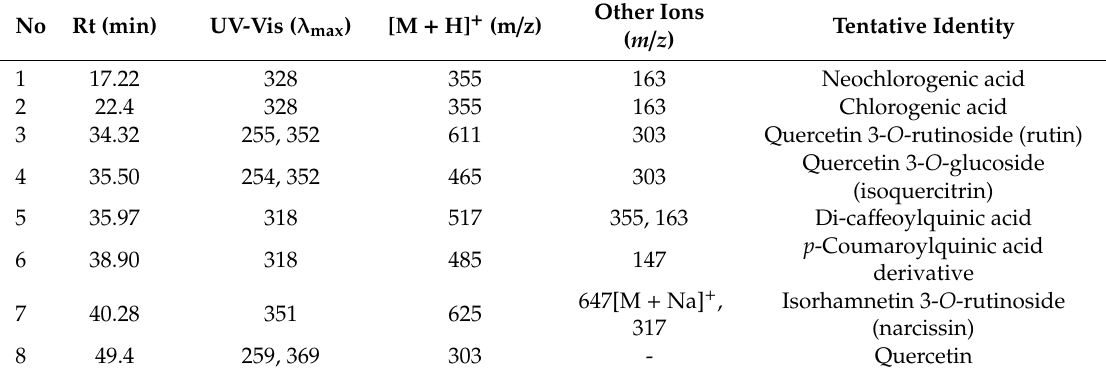
Table 4. Spectral information for the principal polyphenolic constituents tentatively identified in the EBF extract obtained under optimal conditions, at 80 ◦ C.